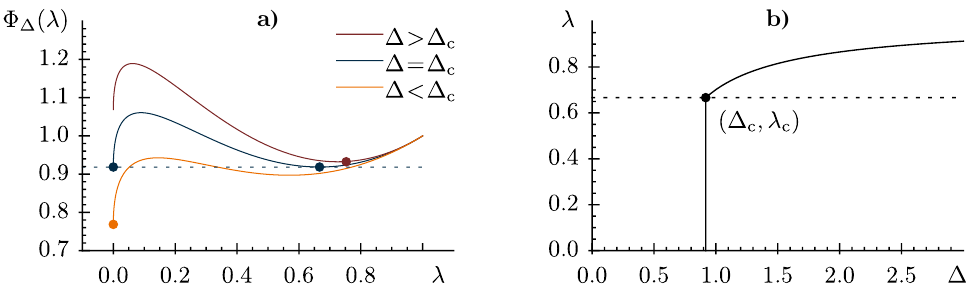
Figure 3: a) Free-energy functional Φ ∆ ( λ ) for different rescaled densities ∆ . At the transition density, phase coexistence is indicated through the two solutions, the oversaturated vapour with no droplet ( λ = 0) and the equilibrium droplet with sur- = 2 / 3). b) Plot of the analytic solution for the rescaled droplet rounding vapour ( λ c size λ ( ∆ )